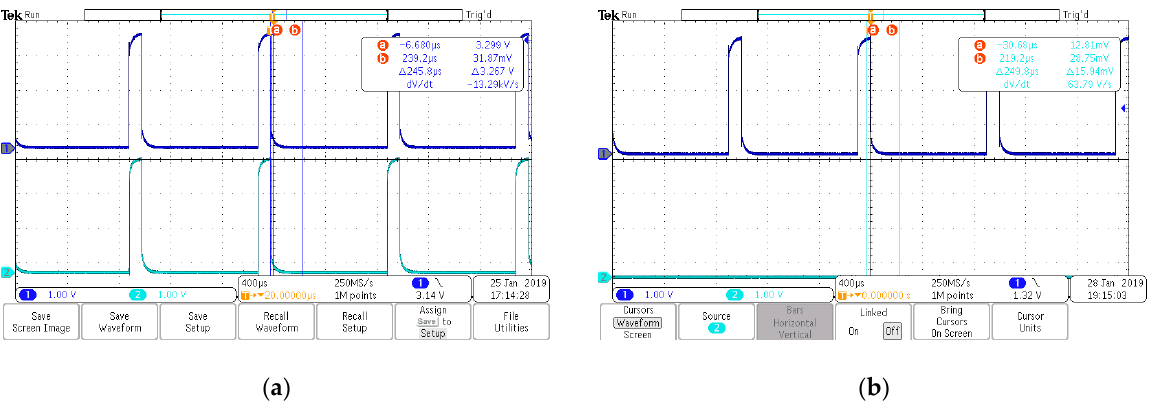
Figure 10. Functionality tests performed on one sample after CDM stress: ( a ) transient signals shown on oscilloscope for first row stressed at 500 V; ( b ) transient signals shown on oscilloscope for last row stressed at 2 kV.